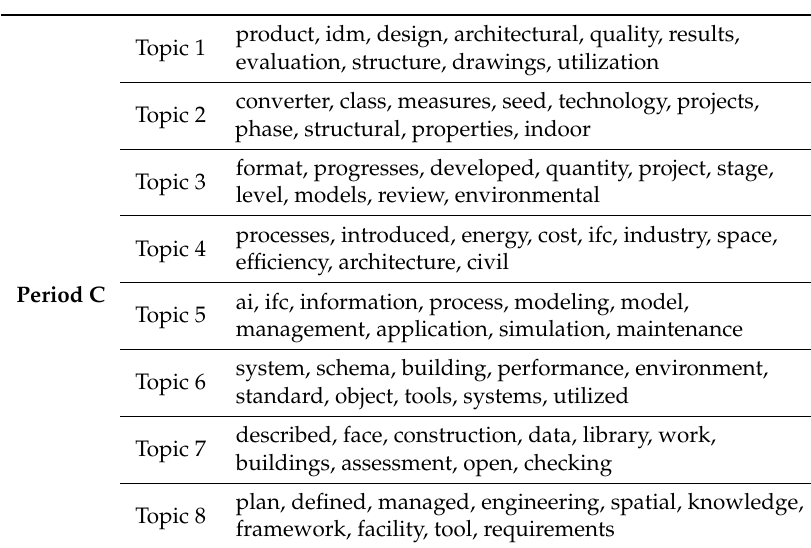
Table 7. Topic analysis result of Period C